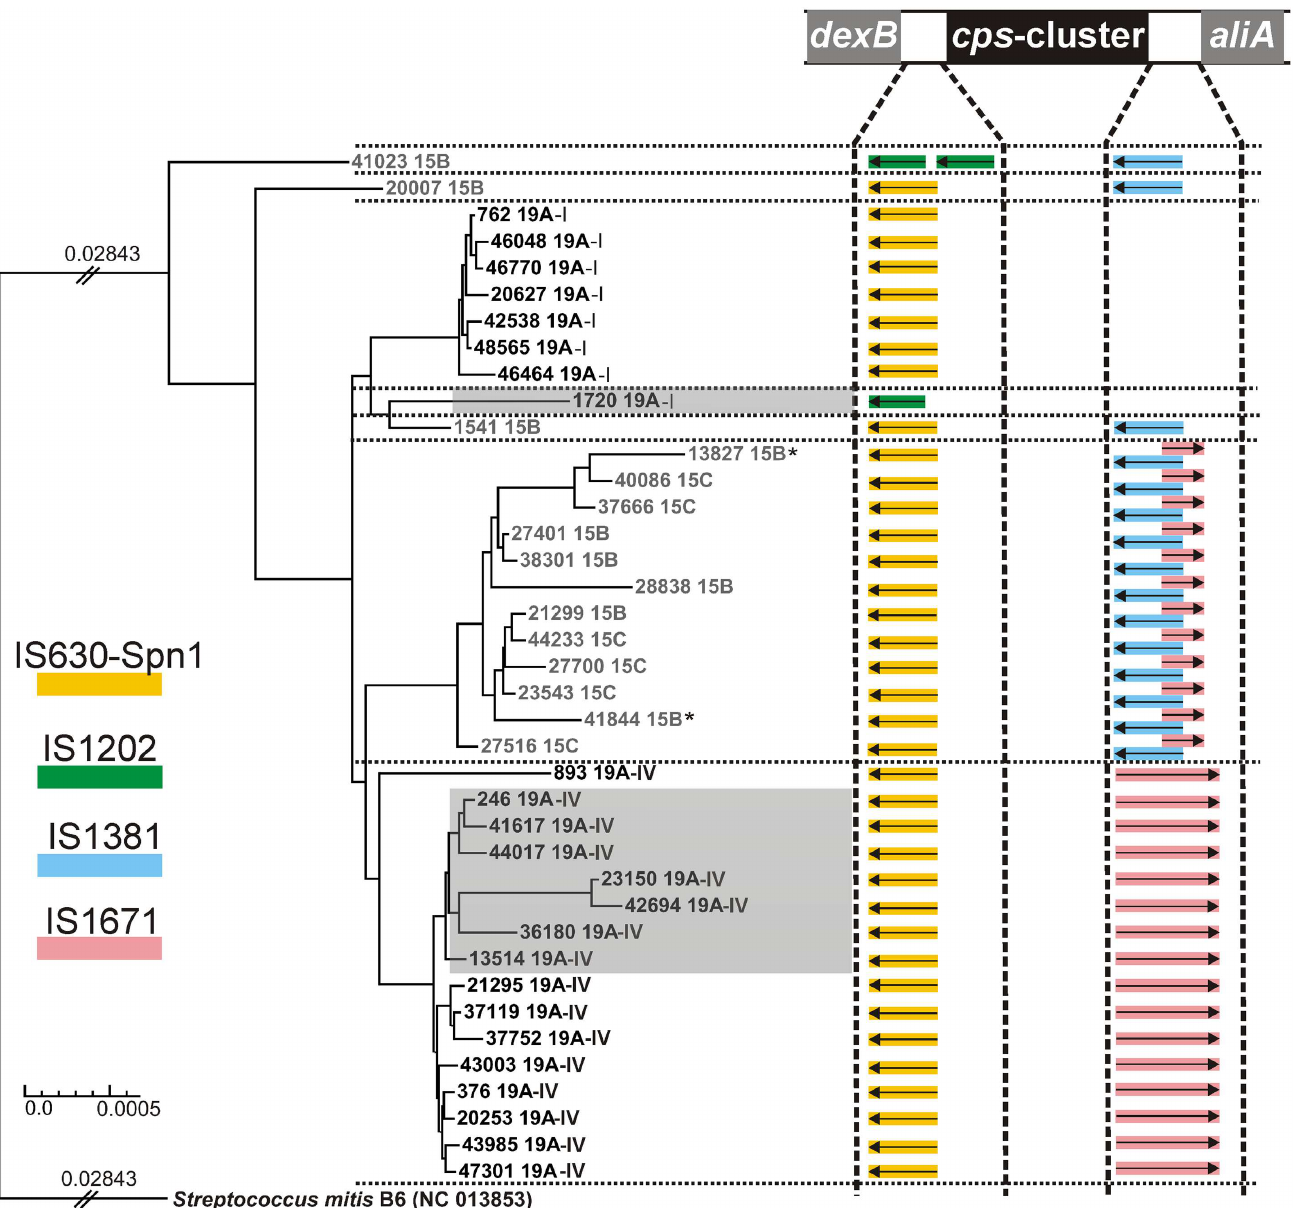
Fig 3. Phylogenetic relationship based on the core genome of 1388 genes derived from the 39 S . pneumoniae isolates with ST199 and Streptococcus mitis (as outgroup). The two isolates with phage-specific sequencesthat could not be assembledinto the chromosomes are indicated by asterisks. The low-levelpenicillin-resistant isolates are underlinedin grey. The transposases ( tnp ) flanking the cps clusters are shown as coloured arrows, and the legendfor the tpn sources is indicatedon the left side. The different constellations of tpn genescorrelatedwith the linagesare separated by dotted